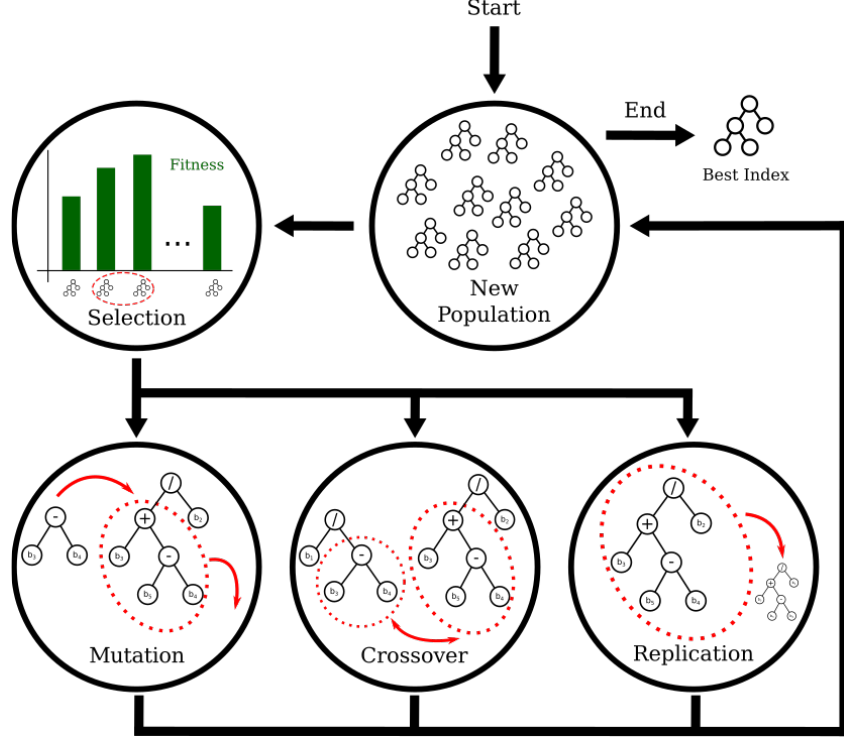
Figure 3. The general genetic programming